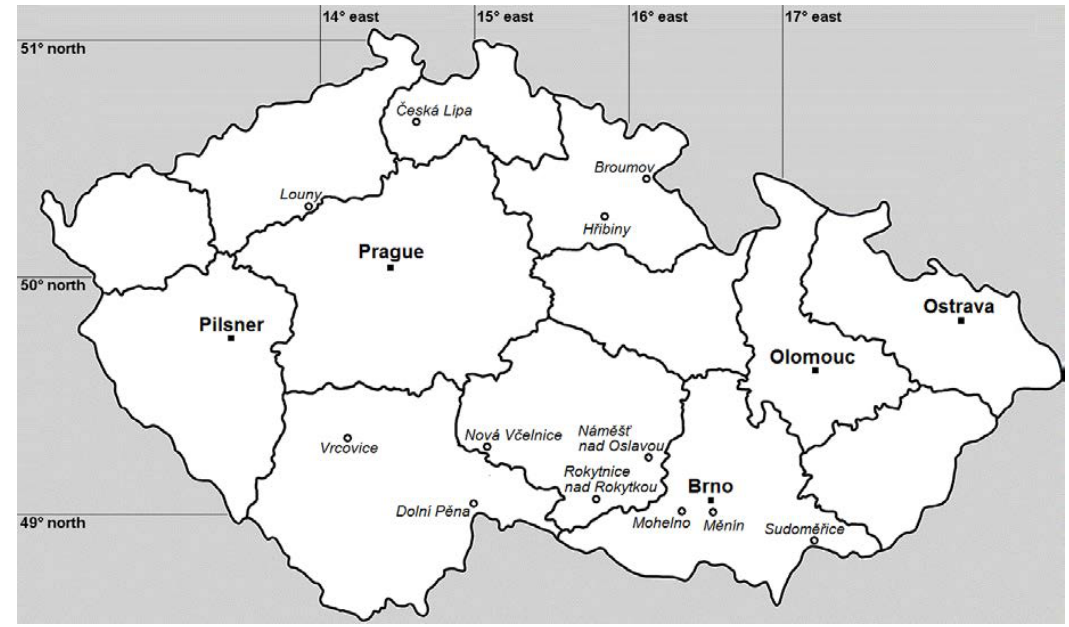
Figure 5. Position of the selected photovoltaic arrays.